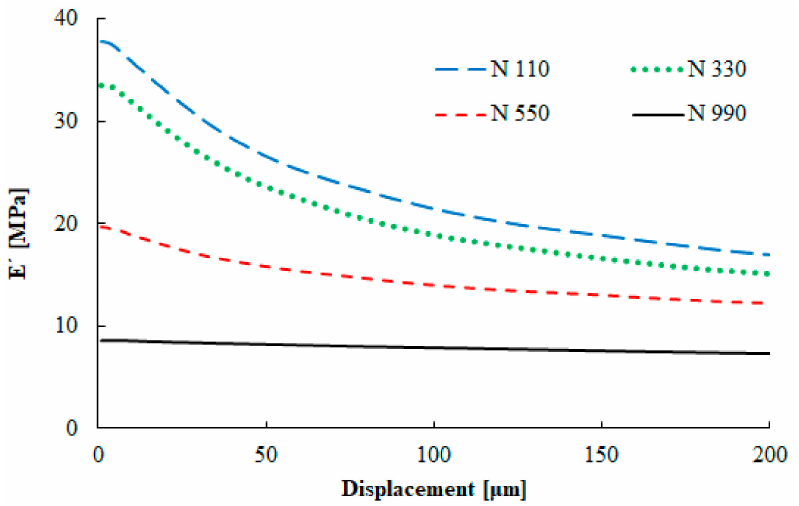
Figure 7. Displacement dependence of the tensile storage modulus (f = 20 Hz, T = 0 ◦ C).